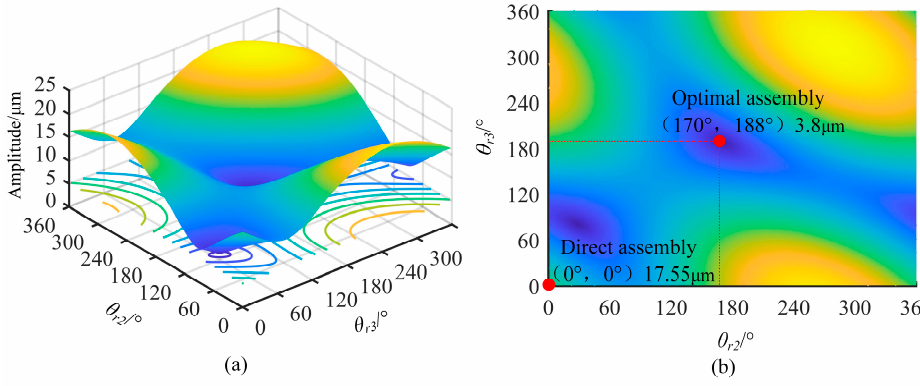
Figure 3. Vibration amplitude control diagram of drive end under working speed of rotary parts rotor system: ( a ) Three-dimensional diagram of vibration amplitude changing with assembly phase; rotor system: ( a ) Three ‐ dimensional diagram of vibration amplitude changing with assembly ( b ) Projection diagram of vibration amplitude changing with assembly phase. phase; ( b ) Projection diagram of vibration amplitude changing with assembly phase.